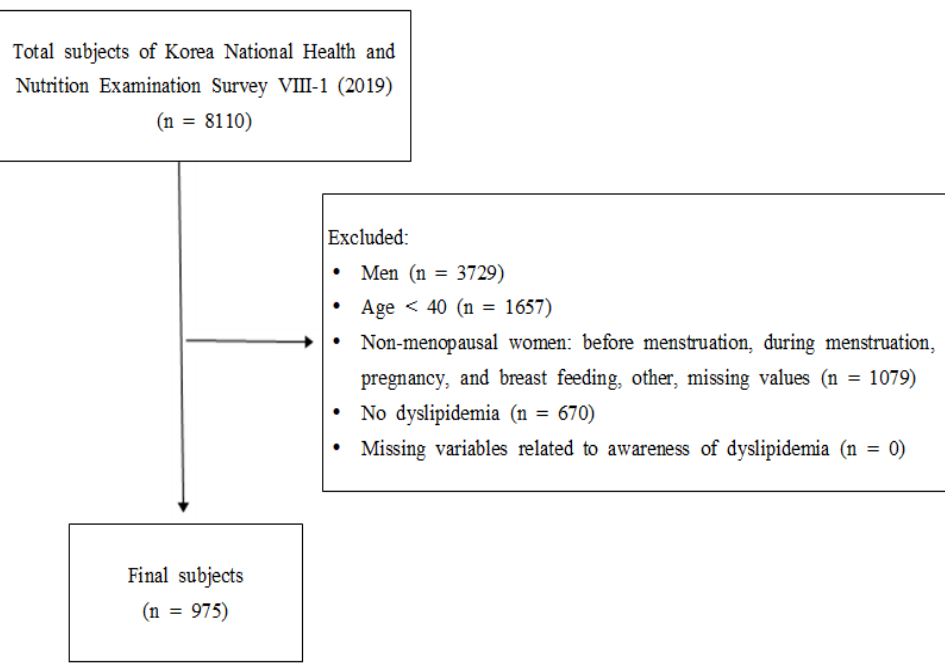
Figure 1. Flowchart depicting the selection of study participants.